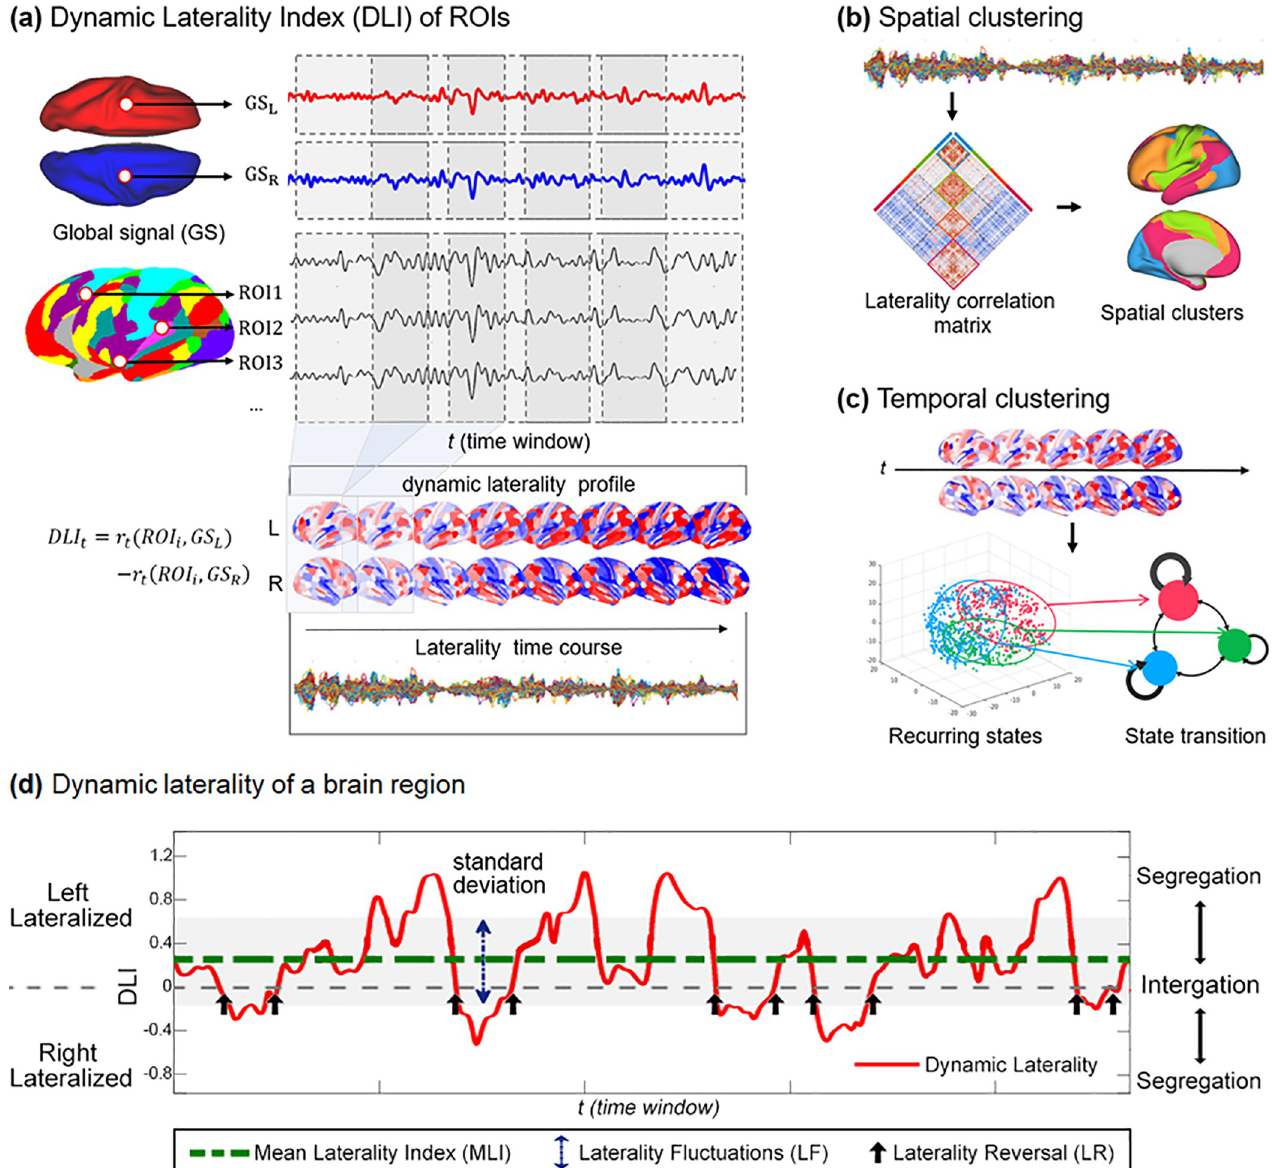
Fig 1. The workflow of dynamic laterality analysis. (a) Definition of the DLI. The DLI of ROI i within time window t is defined as the correlation coefficient (z-transformed) between GS and the ROI minus the correlation coefficient between GS and the ROI. Using a sliding window approach, we obtained a time L R series of DLI for each ROI. (b) Laterality correlation matrix, which is obtained by correlating laterality time series across all ROIs. Spatial clustering is then performed to identify spatial clusters of brain regions demonstrating covariation in laterality time series. (c) Temporal clustering of whole-brain laterality patterns, which identifies potential recurring laterality patterns. (d) Illustration of DLI and relevant dynamic laterality measures using an ROI that is left- lateralized. The red curve represents the time series of DLI. The green dotted line is the MLI (0.26), and the blue double arrow denotes the standard deviation of the laterality time series, which measures the level of LFs. The black arrow represents the LR (the change of the sign of lateralization across 2 consecutive time windows). Large magnitude of laterality index indicates segregation at the hemispheric level, while small magnitude of laterality index (near 0) indicates integration across 2 hemispheres. DLI AU : AbbreviationlistshavebeencompiledforthoseusedinFigs 1 (cid:0) 7 : Pleaseverifythatallentriesarecorrect : , dynamic laterality index; GS, global signal; GS , global signal of the left hemisphere; GS , global signal of the right L R hemisphere; LF, laterality fluctuation; LR, laterality reversal; MLI, mean laterality index; ROI, region of